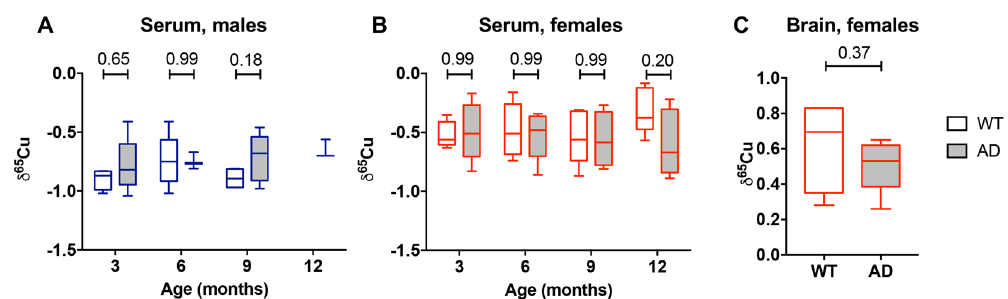
Figure 3. Effect of AD on Cu isotopic composition. ( A , B ). Data show δ 65 Cu values from serum of WT and AD mice. Two-way ANOVA showed no significant effect of age or genotype for serum in males ( A ) or females ( B ). p values between WT and AD are indicated on the graphic for each age (Sidak’s multiple comparison test). ( C ) δ 65 Cu in the brain of 12-month-old females. p = 0.37, Mann-Whitney